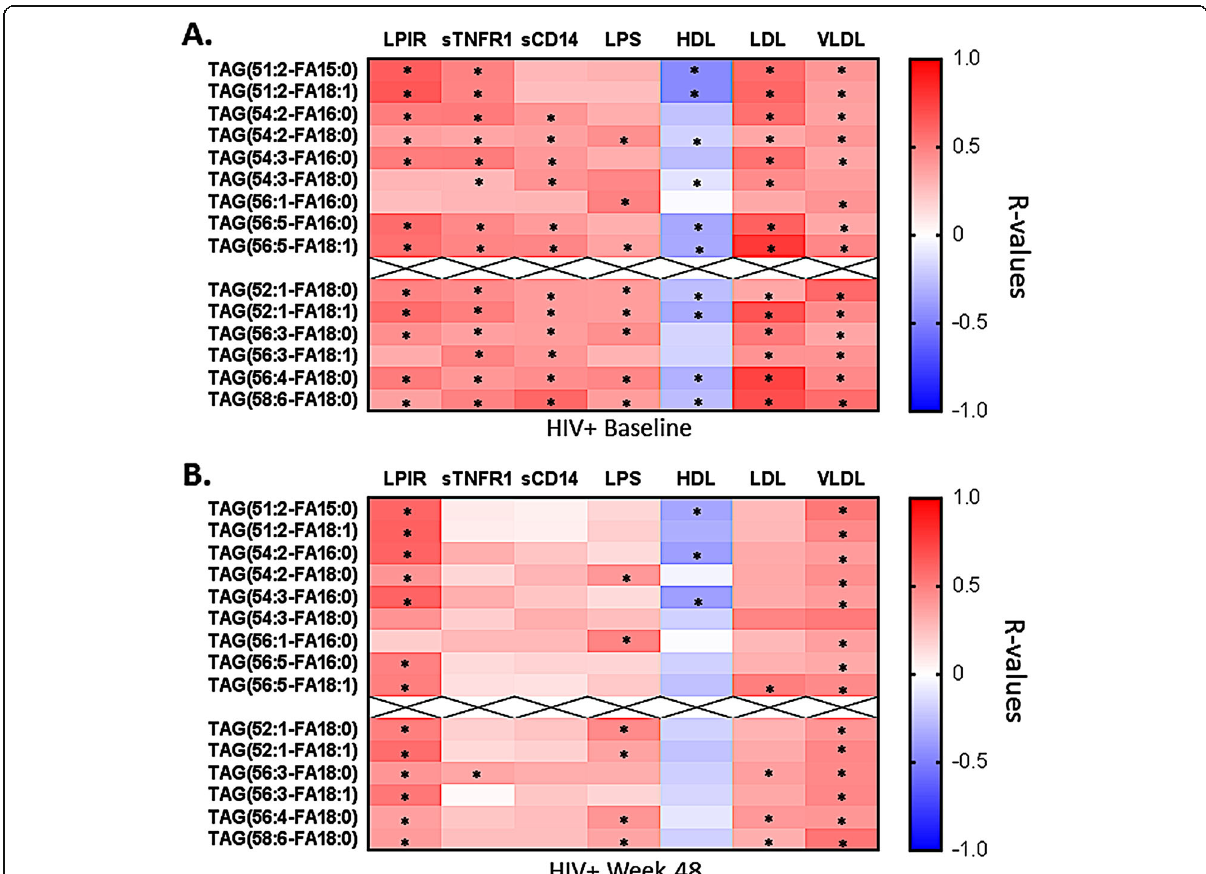
Fig. 2 TAG species composed of saturated fatty acids are associated with inflammatory biomarkers and clinical indices. Associations among concentrations ( μ M) of TAGs and inflammatory and clinical markers from samples from a untreated HIV+ individuals and b following 48weeks of ART are reported. TAG species above the hashmark have been previously associated with CVD, and TAGs below the hashmark are species that have not been linked to CVD in the general population, but have similar relationships to inflammatory biomarkers and traditional lipid measurements. Spearman correlations are reported for all associations. (* p